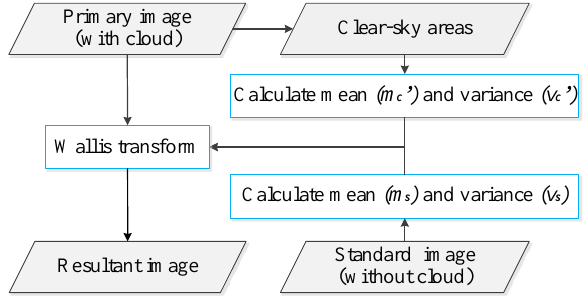
Figure 4. Flow chart of modified Wallis transform